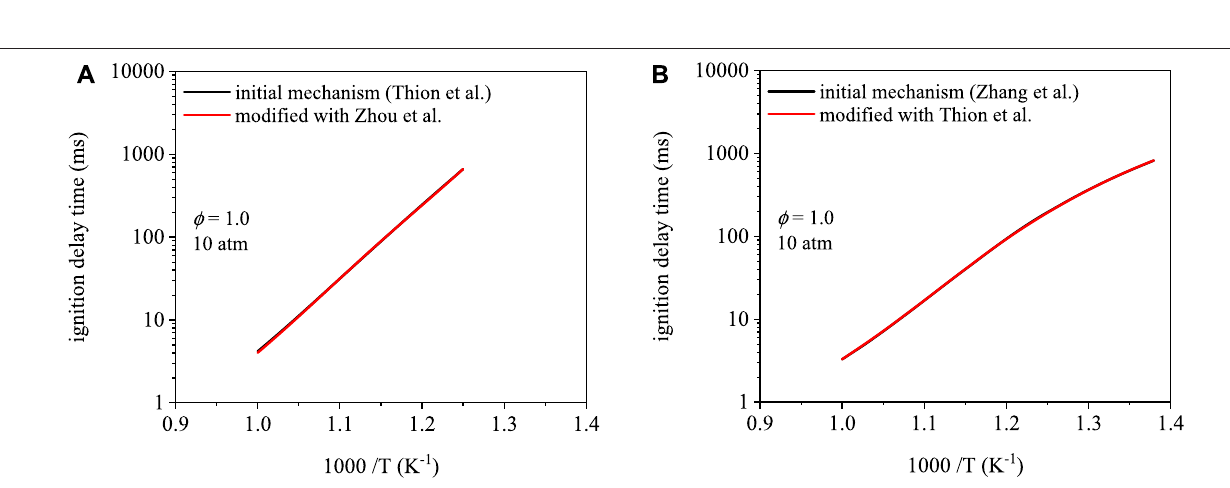
Frontiers in Mechanical Engineering |